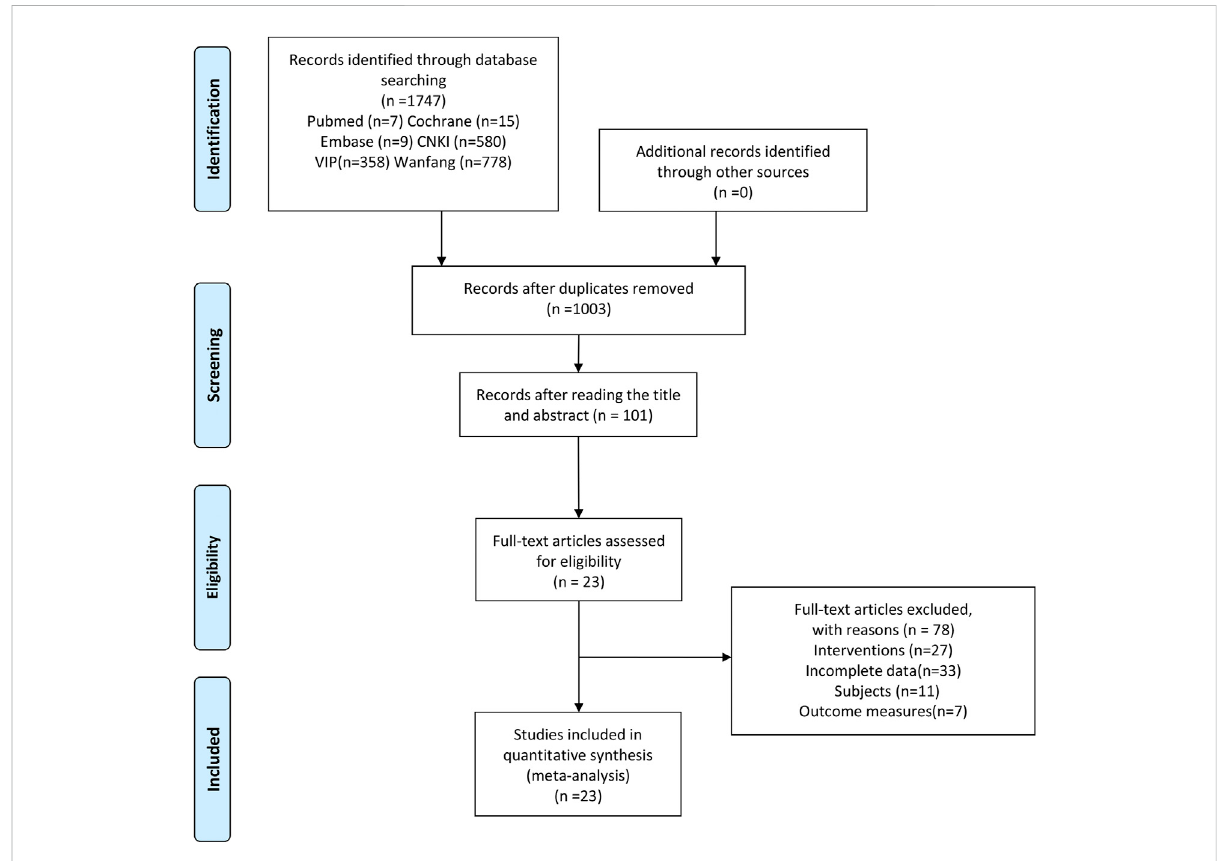
FIGURE 1 Flow diagram of the study selection